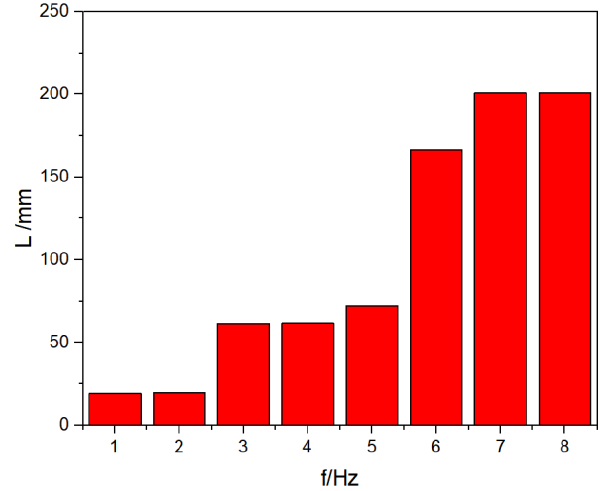
Figure 20. Frequency of L which value is 225 mm. If L value is 200 mm, which is as Figure 21.